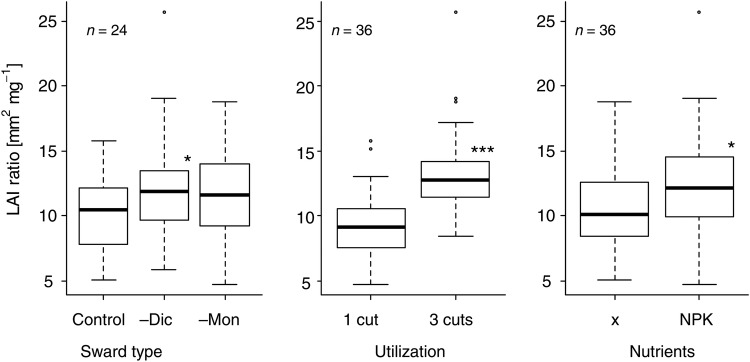
Leaf area ratio (median, first and third quartiles) per experimental factor in July 2009. For abbreviations of factors, refer to Table 1. Asterisks denote significant differences of factor levels compared with the reference level (sward control, utilization 1 cut, nutrients x) in a linear model (with log transformation of the response variable for comparison of treatments). ***P < 0.001, **P < 0.01, *P < 0.05.